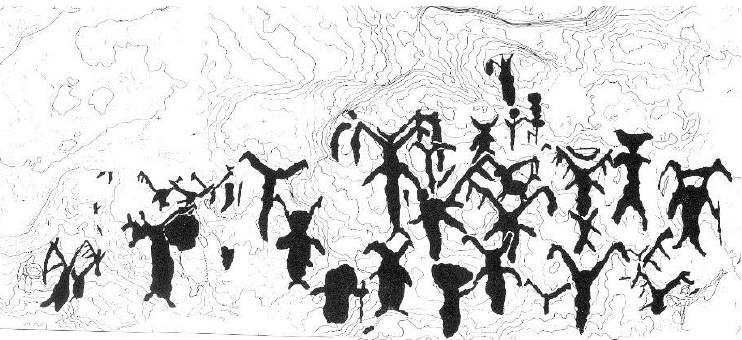
Figure 9. Petroglyphs from